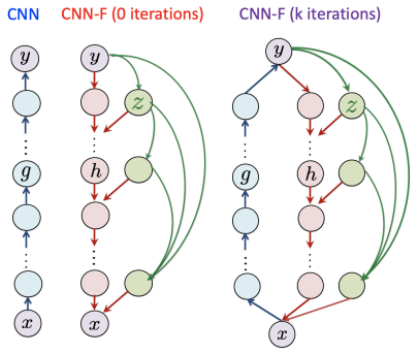
Figure 26. Sequential graphical model of the CNN-F (k iterations). Latent variables ( z ) are inferred by propagating along both bottom-up and top-down pathways.